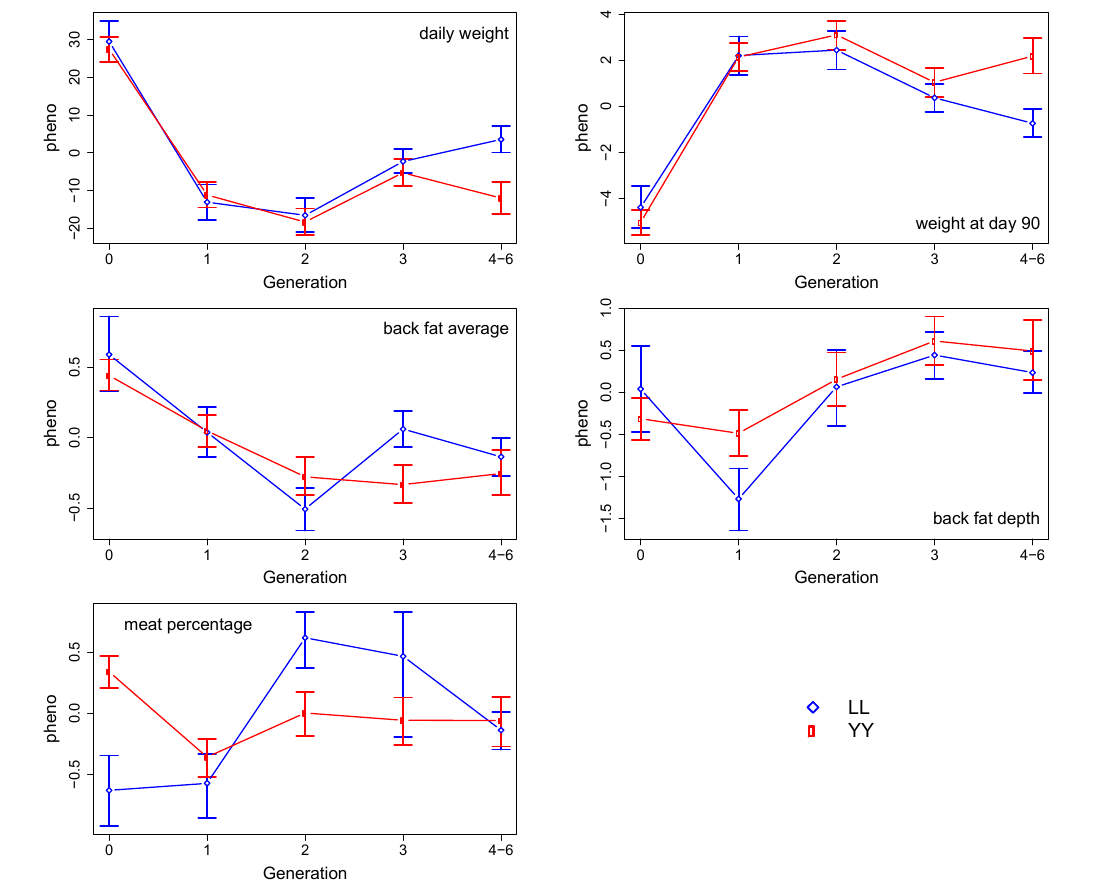
Figure 2. 95% bootstrap confidence intervals from 1,000,000 resamples of the phenotypic values (corrected for fixed effects) by breed (Landrace (LL) and Yorkshire (YY)) and generations (zero to six).